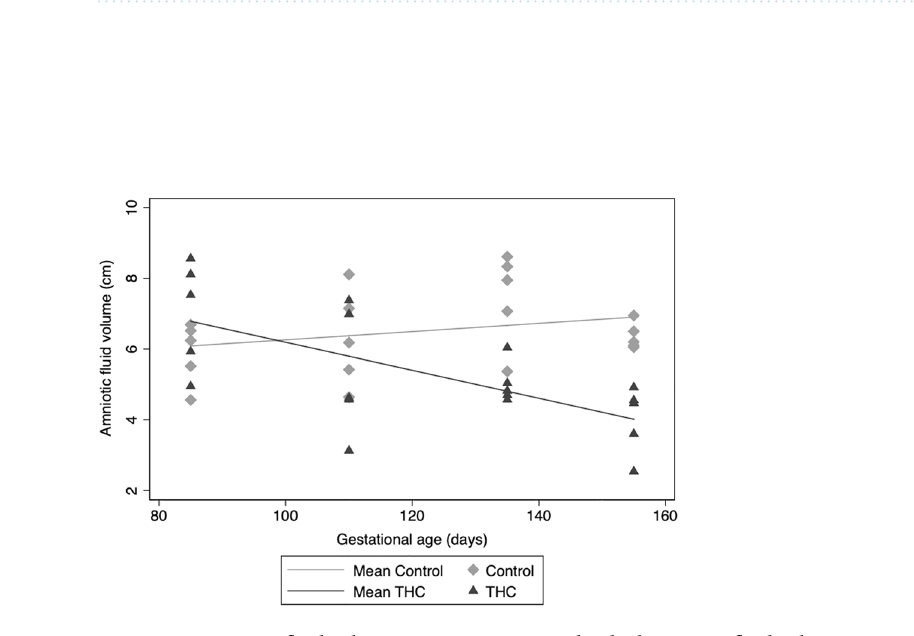
Figure 2. Amniotic fluid volume across gestation. Individual amniotic fluid volume measurements at four gestational time points. With increasing gestation, we observed a significant decrease in average change per 25 days of gestation in amniotic fluid volume in the THC-exposed (n = 5) vs. control (n = 5) pregnancies (p <